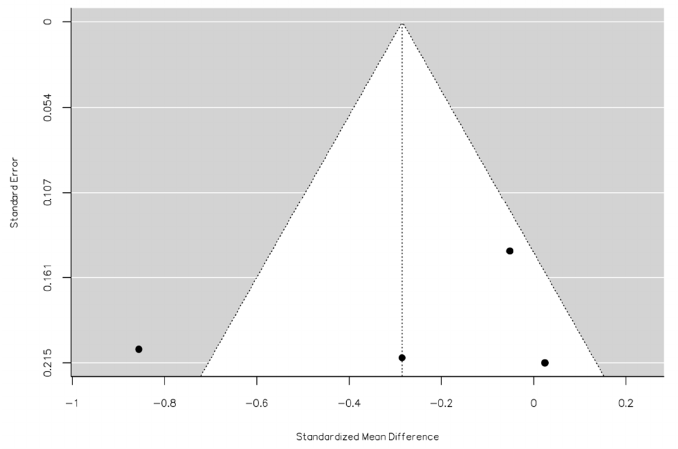
Figure 3. Funnel plot of meta-analysis regarding age of onset of SSNHL patients in the pandemic year period vs. pre-pandemic year period. Black dots identify each study’s characteristics in terms of standard error and standardized mean difference.